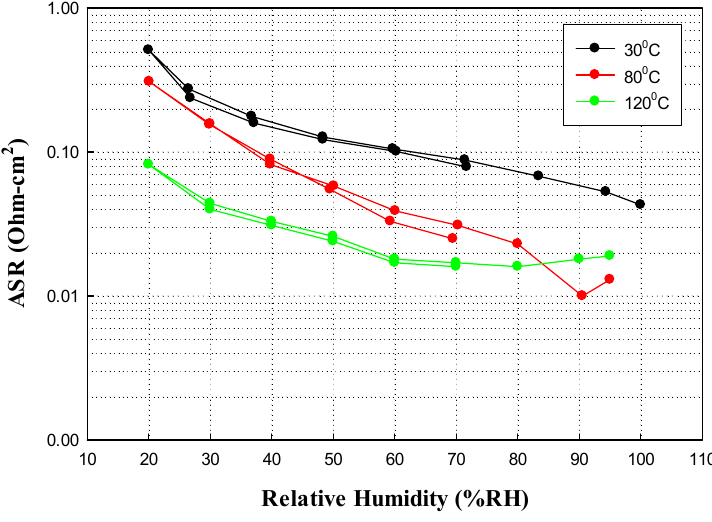
Figure 12. Through-plane area specific resistance (ASR) for the mC2 membranes measured at 30, 80, and 120 °C showing an average ASR of 0.025 Ohm cm 2 at 50% RH and 120 °C compared to the DOE target of <0.02 Ohm cm 2